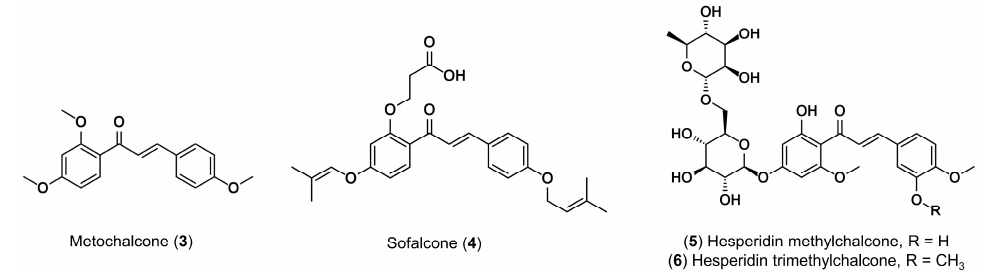
Figure 2. Chemical structures of approved and clinically tested chalcones.